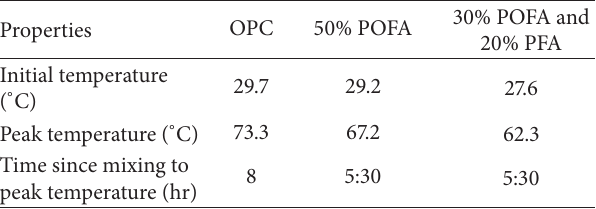
Table 5: Characteristic of heat of hydration of OPC and POFA-PFA aerated